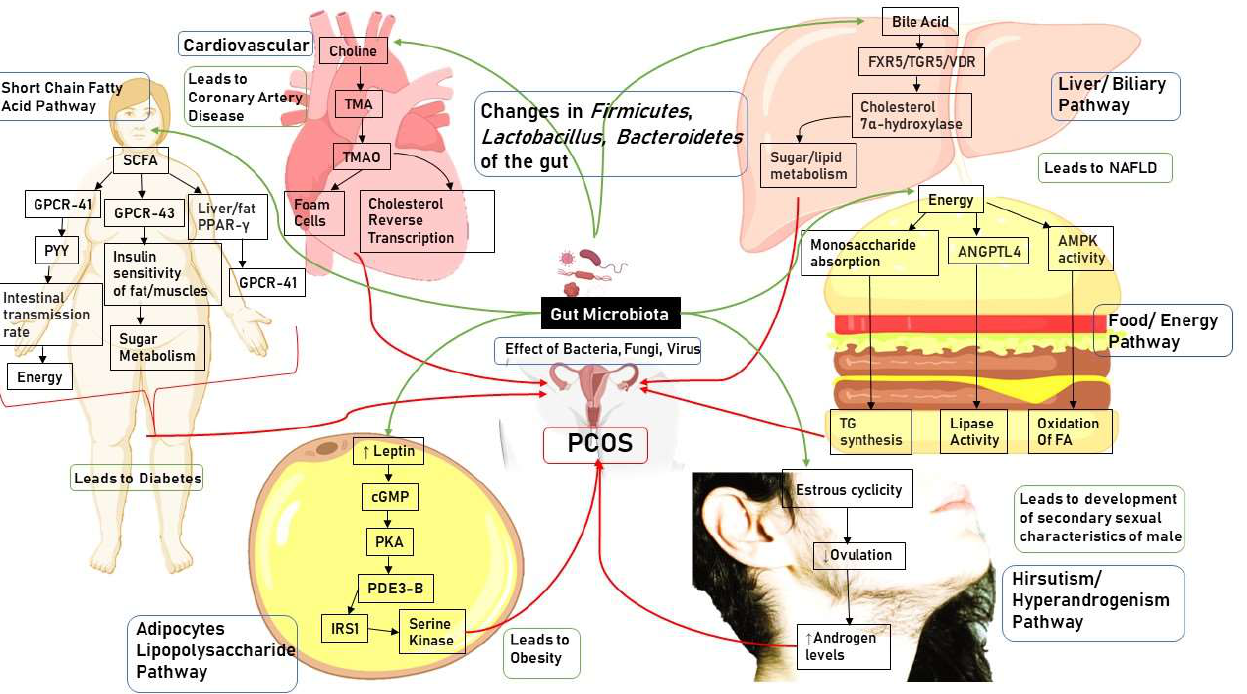
Figure 1. Role of gut microbiota in the cause of PCOS. AMPK : 5′ Adenosine Monophosphateactivated Protein Kinase; ANGPTL4: 520 Angiopoietin-like 4; cGMP: Cyclic Guanosine Monophosphate; FA: Fatty Acids; FXR5: Farnesoid X Receptor 5; GLP-1: Gluca- 521 gon-Like Peptide-1; GPCR-41/43 : G-Protein-Coupled Receptor 41/43; IRS1: Insulin Receptor Substrate 1; LPS: Lipopolysaccha- 522 rides; NAFLD: Non Alcholic Fatty Liver Disease; PDE3-B: Phosphodiesterase 3B; PKA: PPAR-γ: Peroxisome Proliferator-Acti- 523 vated Receptor γ; PKA: Protein Kinase; PYY: Peptide Tyrosine Tyrosine; SCFA: Short Chain Fatty Acids; TG: Triglycerides; 524 TGR5: G-protein-coupled receptor for bile acids TMA: Trimethylamine; TMAO: Trimethylamine oxide; VDR: Vitamin D receptor; 525 ZO-1: Zonula Occludens-1.